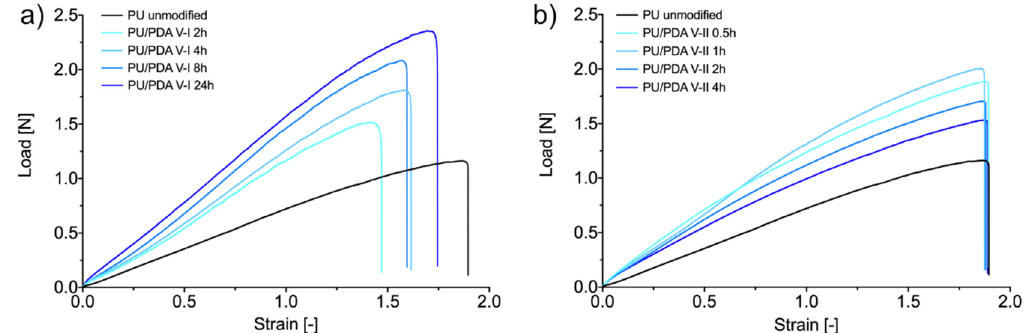
Figure 7. Representative load/strain curves of unmodified and modified PU nanofibrous materials: ( a ) variant I, ( b ) variant II.